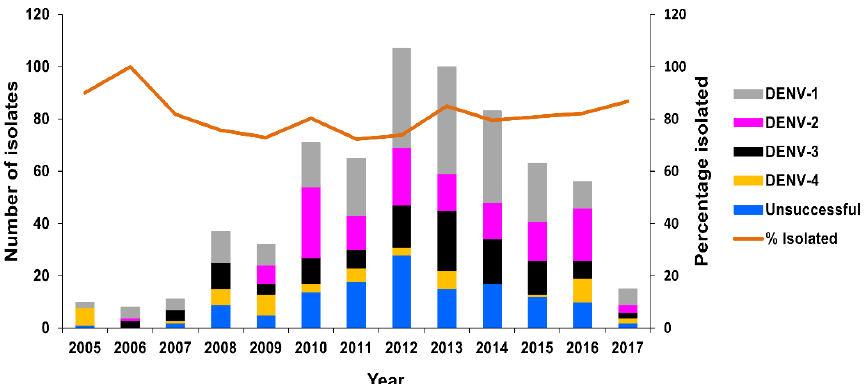
Figure 6. Number of DENV isolates obtained, PHV, 2005 – 2017. The number of RT-rtPCR/RT-PCR-positive samples from which DENV isolates were obtained (grey, pink, black, and yellow bars) or not obtained (blue bar) is highlighted per year. The average percentage of successfully-isolated viruses per year is shown as a line.